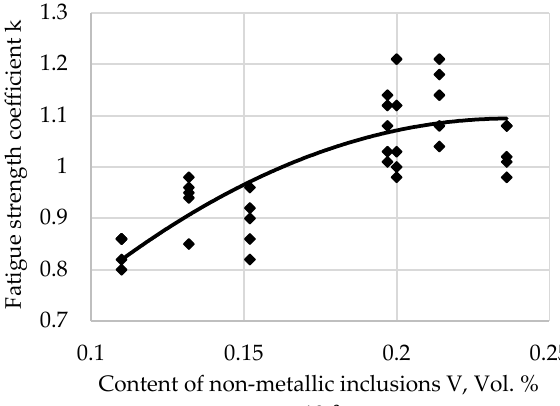
Figure 7. The bending fatigue strength coefficient, k, of research steel after hardening and tempering for all tempering temperatures depends on the relative content of non-metallic inclusions.